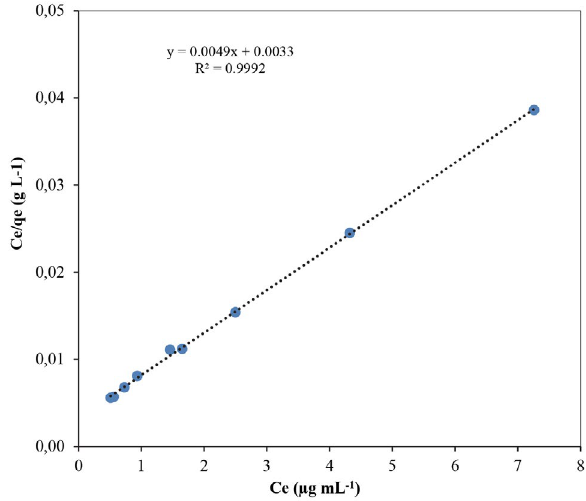
Figure 5. Linear plot of the Langmuir model.